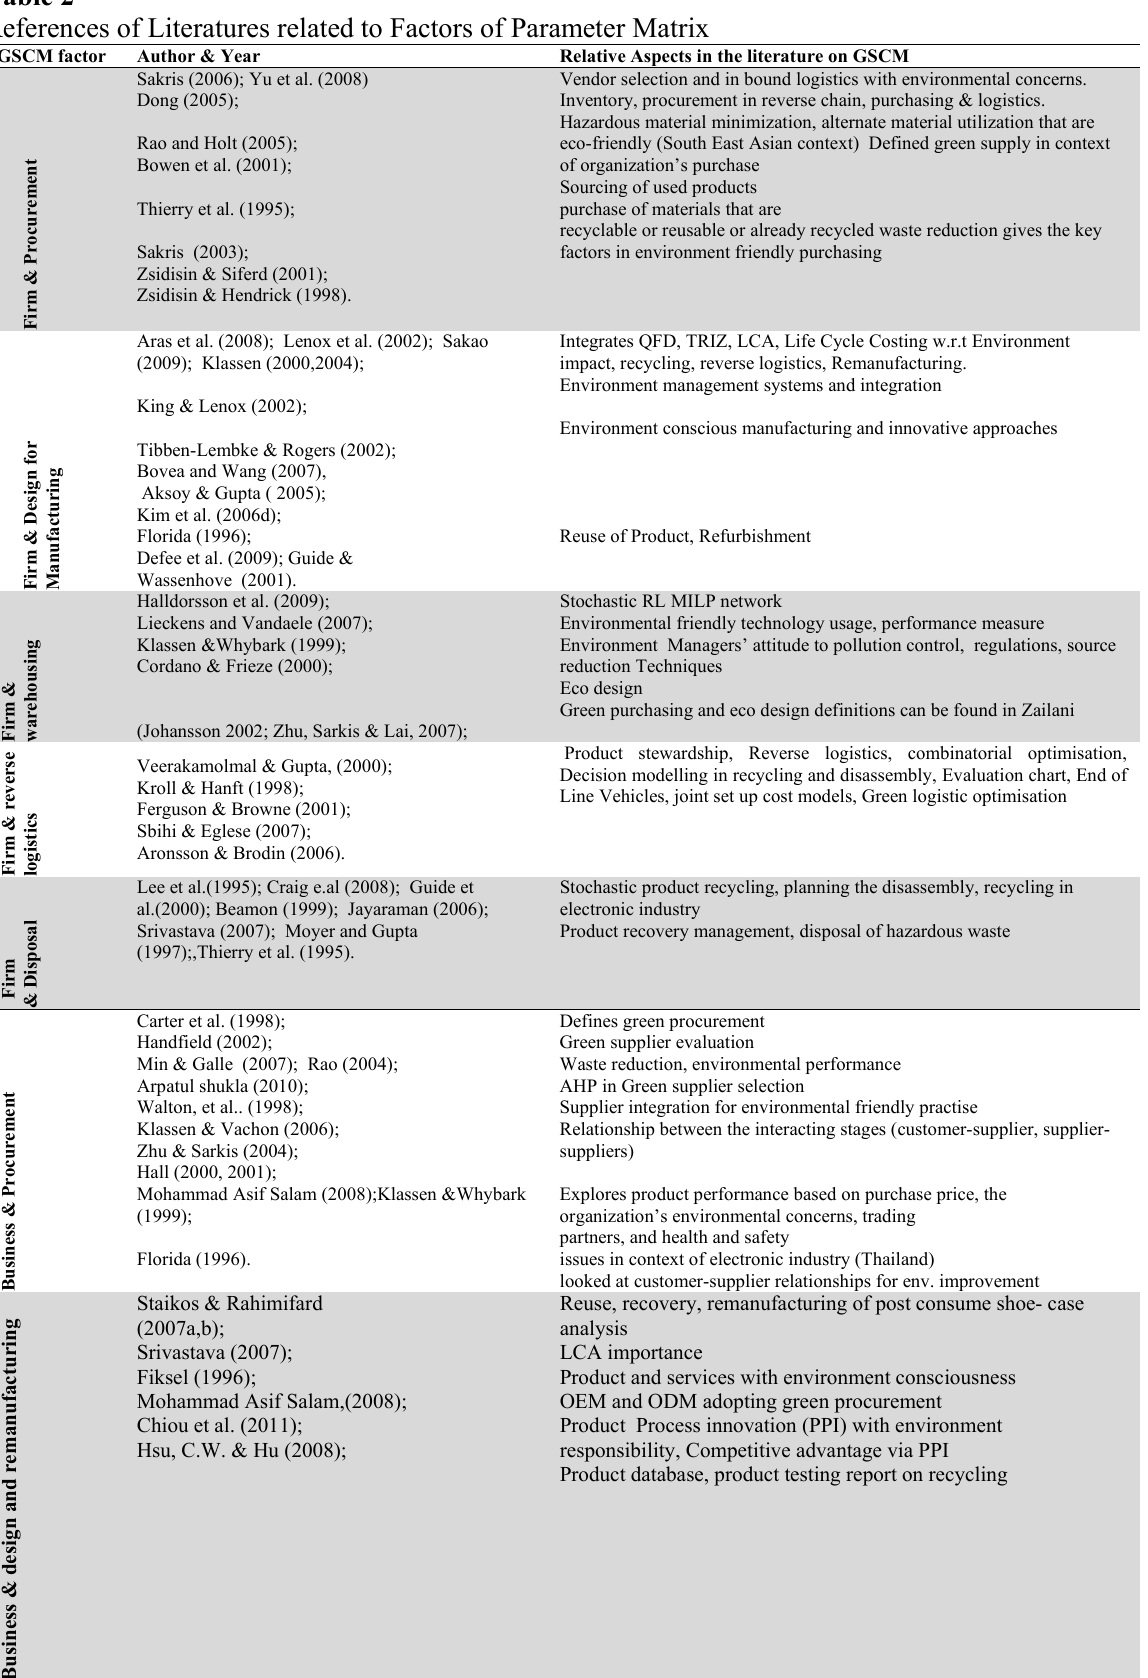
References of Literatures related to Factors of Parameter